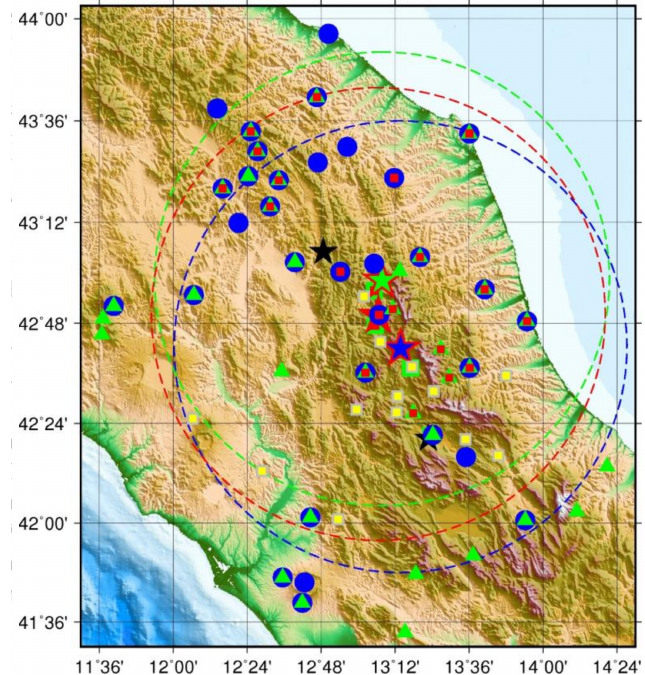
Figure 2. Distribution of clipped seismometers associated with the three mainshocks and the distribution of high-rate GPS stations. Blue star, dashed circle, and dots represent epicenter, 100 km epicentral distance area and clipped broadband seismometers in the Amatrice earthquake. Green star, dashed circle, and triangles represent epicenter, 100 km epicentral distance area and clipped broadband seismometers in the Visso earthquake. Red star, dashed circle, and squares represent epicenter, 100 km epicentral distance area and clipped broadband seismometers in the Norcia earthquake. Yellow squares, location of high-rate GPS